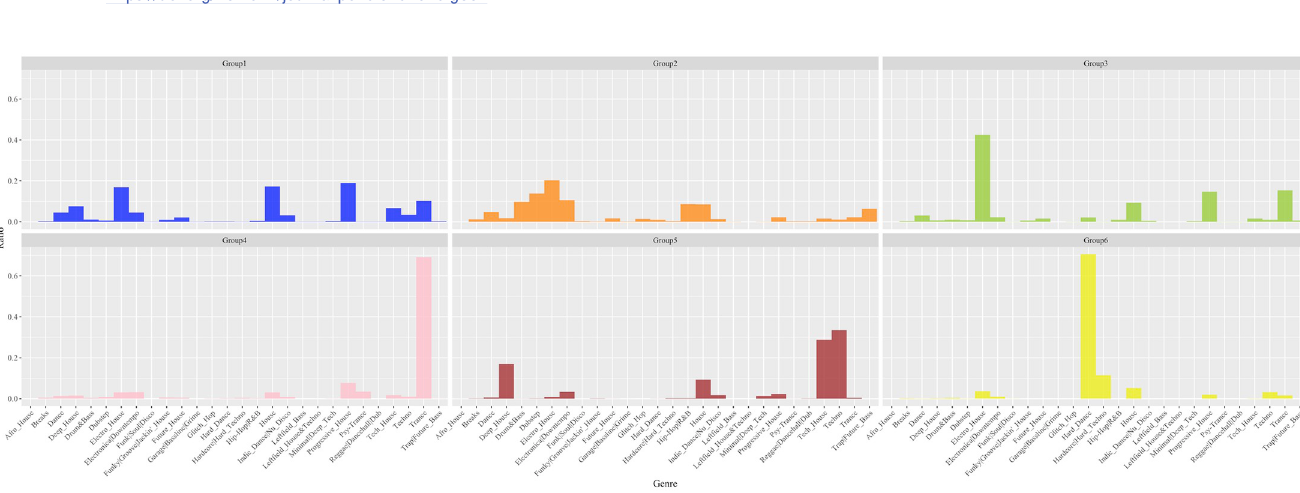
Fig 4. Total citation network of DJs. The figure shows the total citation network of the DJs by adding up the temporal networks from each time window. The node size represents the total number of citations by other DJs. The edge weight is presented by the thickness of the edge.